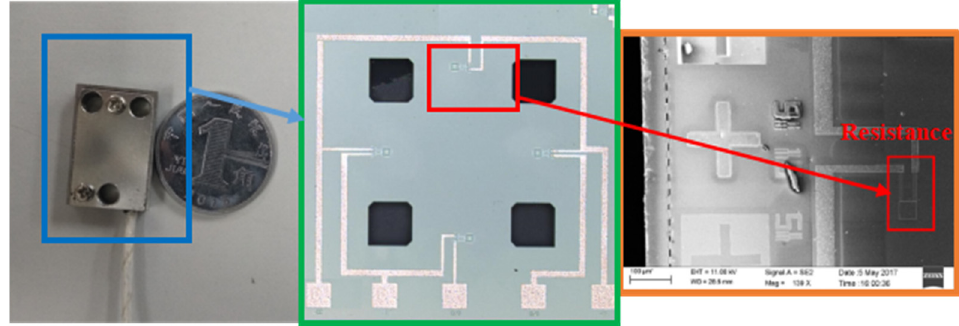
Figure 6. HGMA’s Overall photo, CCD and SEM photos.